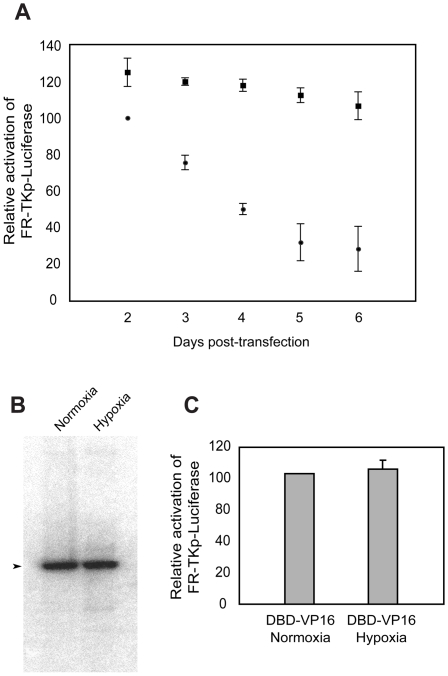
Hypoxic conditions prolong EBNA1's capacity to transactivate.(A) Transactivation by EBNA1 is sustained under hypoxic conditions. C33a cells were co-transfected with an EBNA1-oriP expression plasmid and the oriP-BamHI-Cp-luciferase reporter plasmid. Transfected cells were split six hours post-transfection, and grown under normoxic (filled circles) or hypoxic conditions (filled squares). Luciferase expression was measured at the indicated time-points, and is expressed relative to the luciferase expression observed under normoxic conditions 48 hours post-transfection. (B) Oxygen levels do not affect oriP-plasmid replication and maintenance. A Southern blot was performed to examine the levels of replicated (DpnI-resistant) oriP-BamHI-Cp-luciferase plasmid recovered after six days under normoxic or hypoxic conditions. The arrowhead indicates replicated, full-length oriP-BamHI-Cp-luciferase. (C) Environmental oxygen levels do not alter the activity of DBD-VP16. C33a cells were transfected with a DBD-VP16 expression plasmid and the FR-TKp-luciferase reporter plasmid. Luciferase activity was measured three days post-transfection in cells exposed to normoxic or hypoxic conditions.